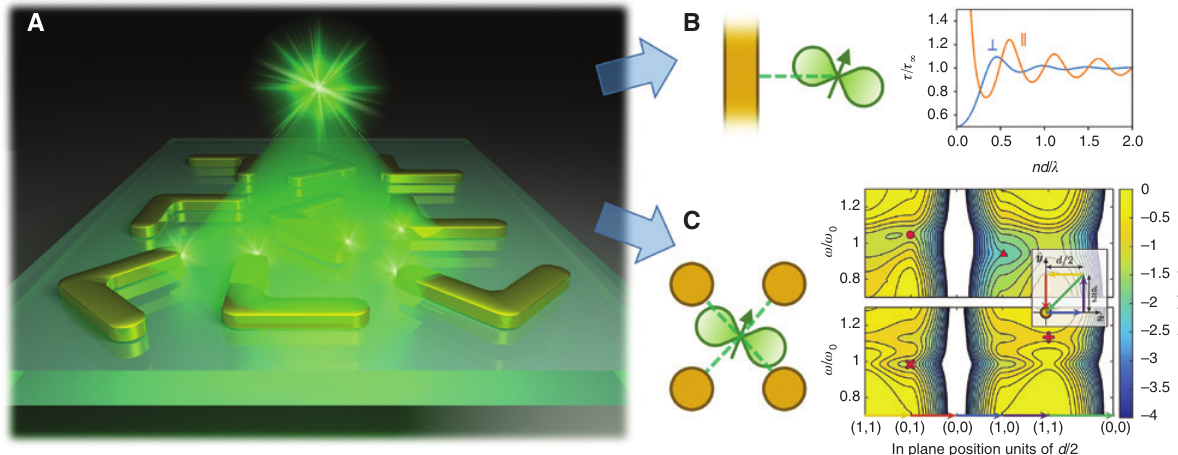
Figure 6: Purcell effect in metasurfaces. (A) Illustration of a single quantum emitter interacting with metasurface scatterers. (B) The effect of the metasurface on the excited state decay time τ can be approximated by that of a mirror placed at a certain distance d from the emitter. Theoretical curves for dipoles oriented parallel (orange) and perpendicular to the mirror (blue) are based on Drexhage’s considerations [83]. (C) In general, the lateral distribution of local density of states (LDOS) across a metasurface is not uniform. The two-dimensional color map reprinted from [84] exemplifies the spectral dependence of the relative lifetime of a dipole emitter placed in the plane of an electric isotropically scattering lattice, as a function of emission frequency and in-plane position along straight paths as illustrated by the colored arrows and the inset. Top: dipole parallel to the lattice. Bottom: dipole perpendicular to the lattice. Markers illustrate different positions of the emitter. Reprinted from [84], https://doi. org/10.1038/srep20655, under the Creative Commons Attribution 4.0 International